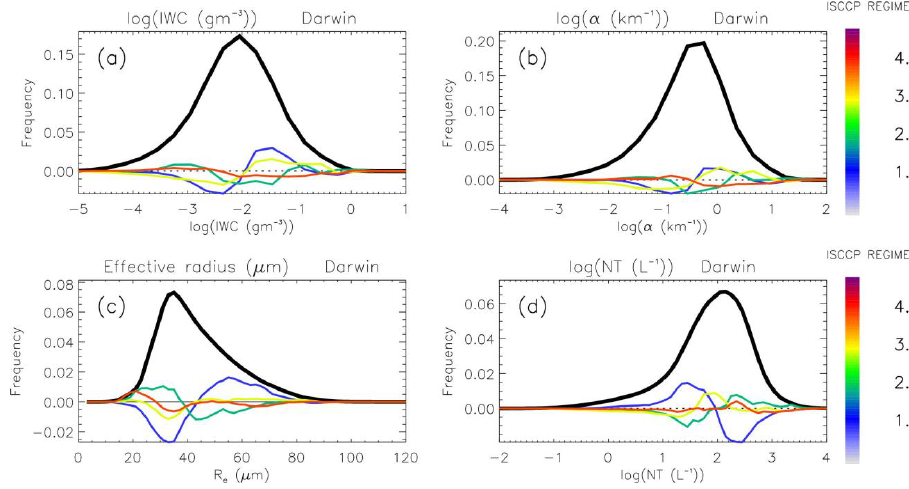
Figure 14: Same as Fig. 7 but for the ISCCP regimes: CD (blue), STC (green), CC (yellow), and MIX (red).